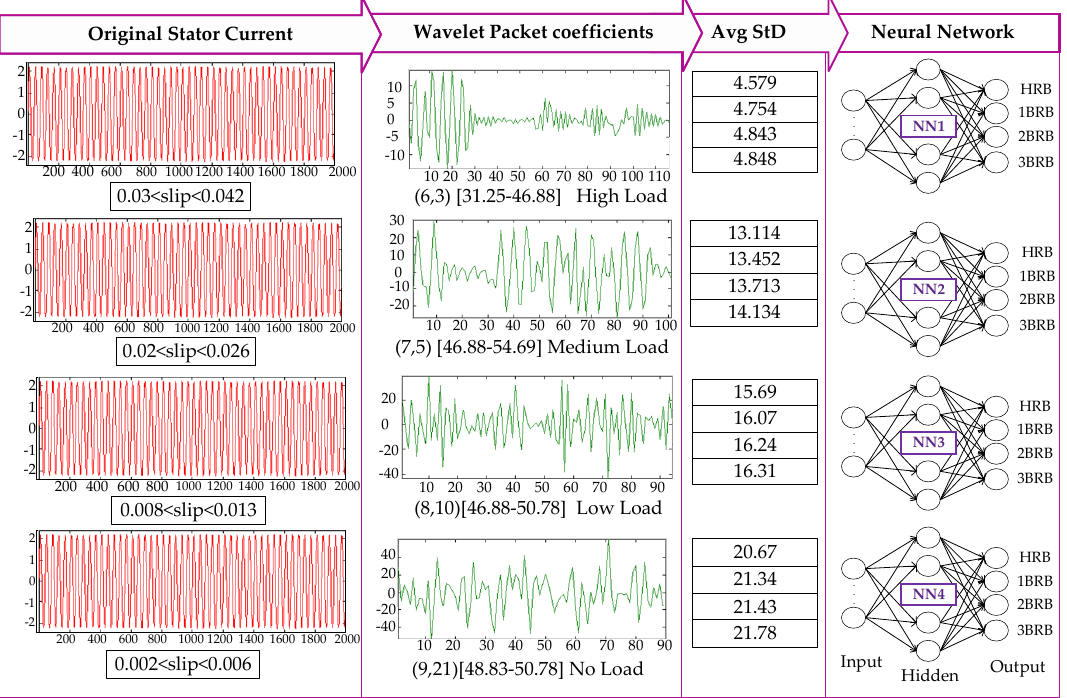
Figure 7. Schematic diagram of the multi ‐ layer perceptron (MLP) network Classifier.